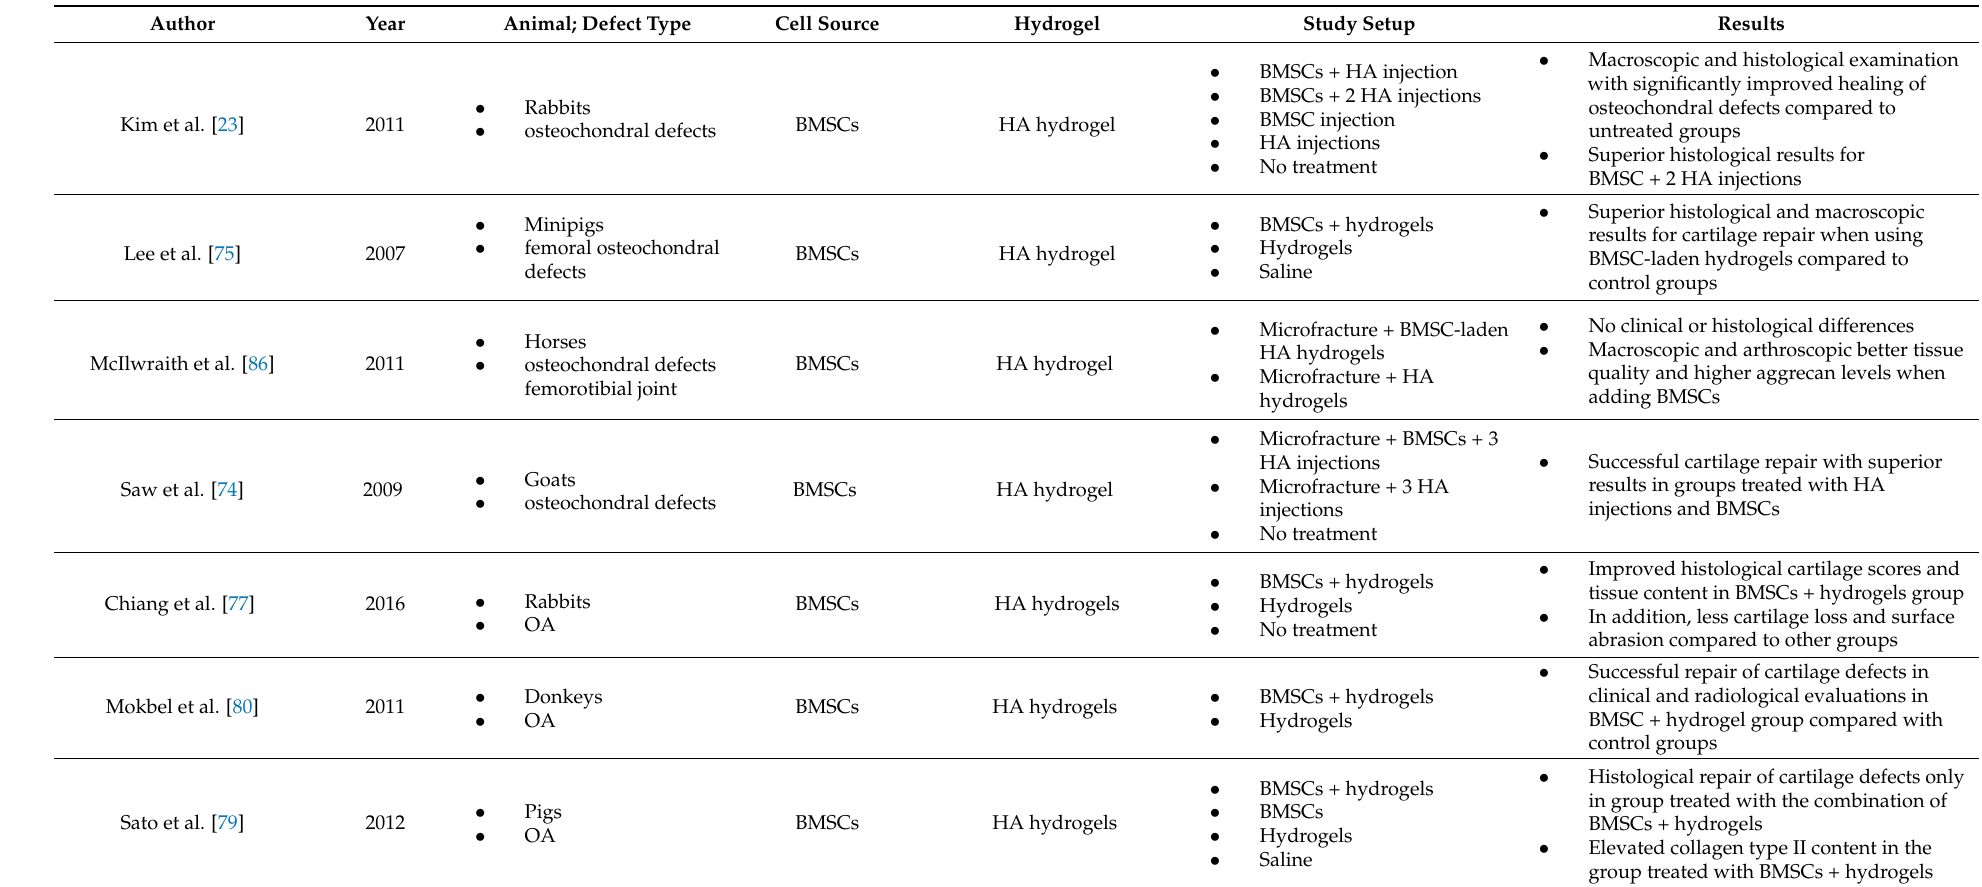
Table 2. Preclinical studies examining the use of MSC-laden hydrogels for cartilage